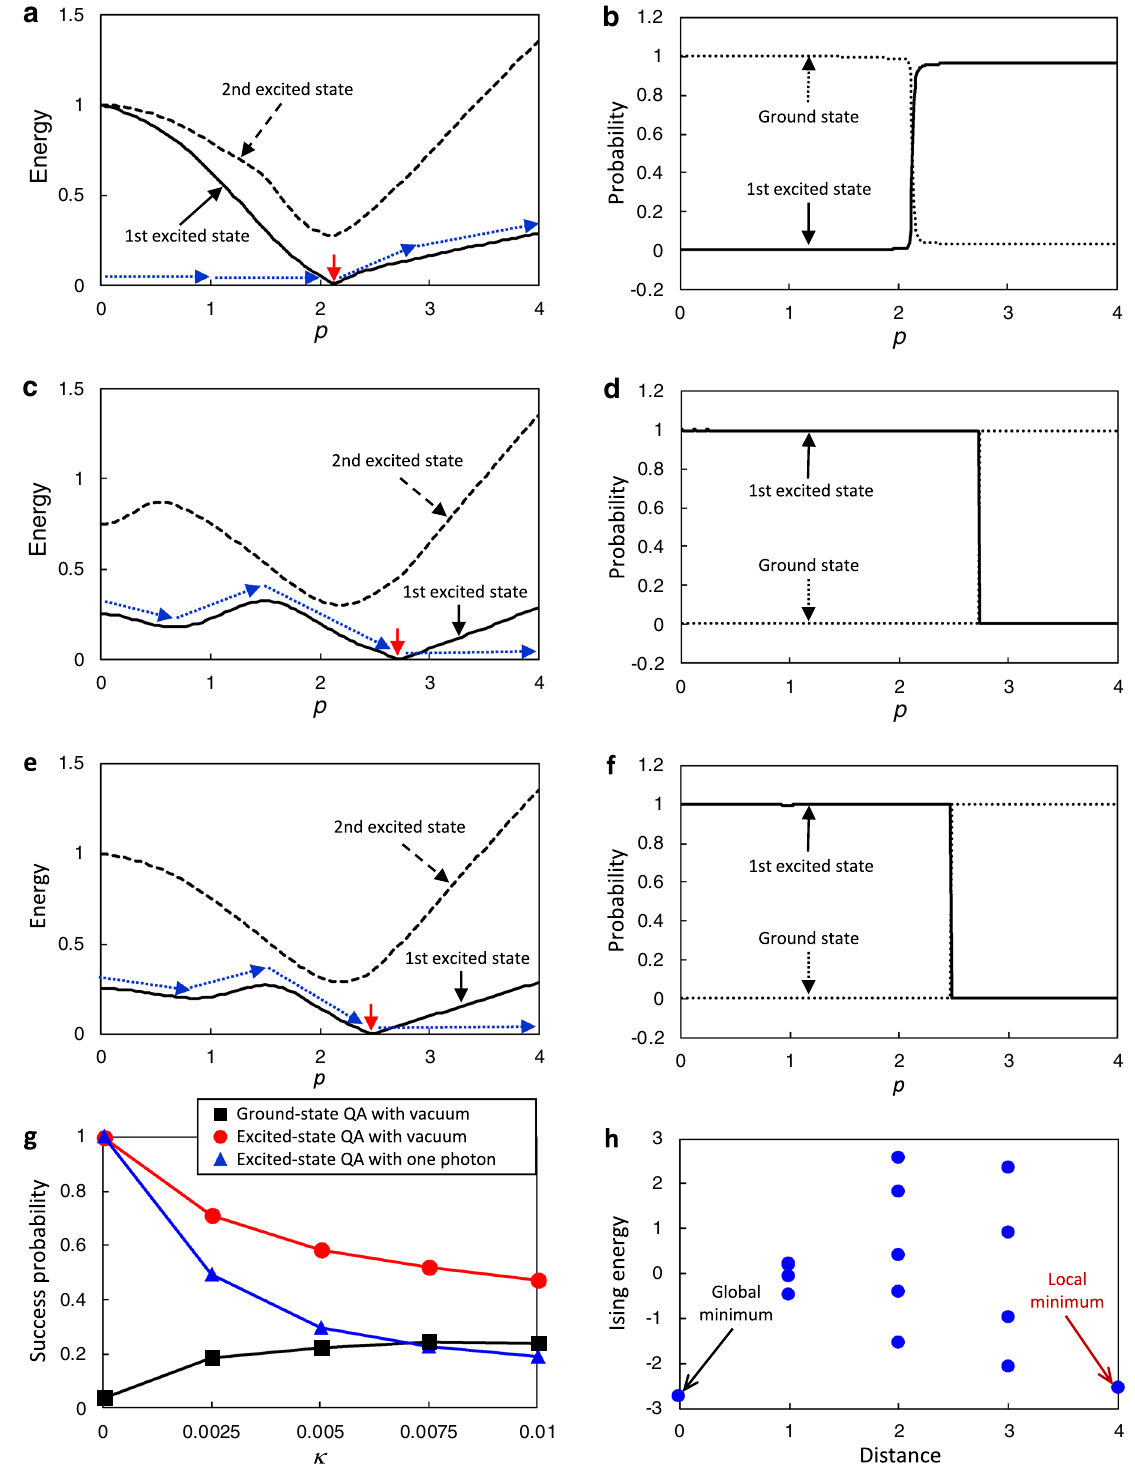
Fig. 3 Characterization of the worst instance of ground-state quantum annealing. The instance is indicated by a red vertical arrow in Fig. 1a. a Energy level of the fi rst (solid line) and second (dashed line) excited states from the ground level as a function of pump amplitude p in the ground-state quantum annealing (QA) with a network of Kerr-nonlinear parametric oscillators (KPOs). (The reduced Planck constant and the Kerr coef fi cient are set as ℏ = 1 and K = 1, respectively.) The vertical arrow indicates energy-gap closing. The dotted arrows depict time evolution of the state. b Time evolution of the population of ground (dotted line) and fi rst excited (solid line) states in a . c , d Results corresponding to a and b , respectively, when the same instance is solved by the proposed excited-state QA. e , f Results corresponding to a and b , respectively, when the same instance is solved by QA started with a physical excited (one-photon) state. g Success probability as a function of a fi eld decay rate κ for each KPO. h Energy landscape of this instance. The value of the horizontal axis is the Hamming distance between the optimal solution (global minimum) and each con fi guration. The Hamming distance between two spin con fi gurations, { s i } and f s 0 i g , is de fi ned by the number of spin pairs, ð s i ; s 0 i Þ , satisfying s i ≠ s 0 i